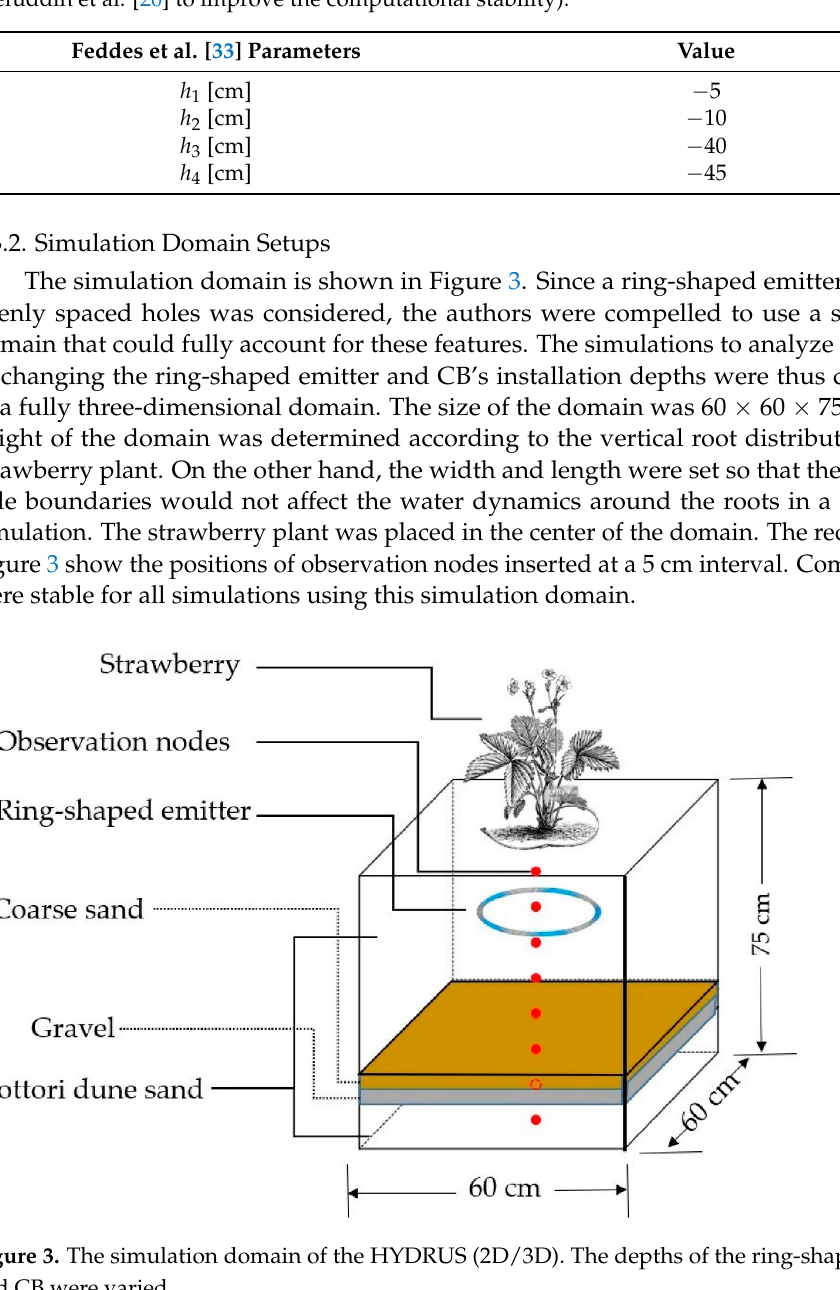
Table 3. The Feddes et al. [33] parameters for strawberries (modified from those presented in Saefuddin et al. [20] to improve the computational stability).